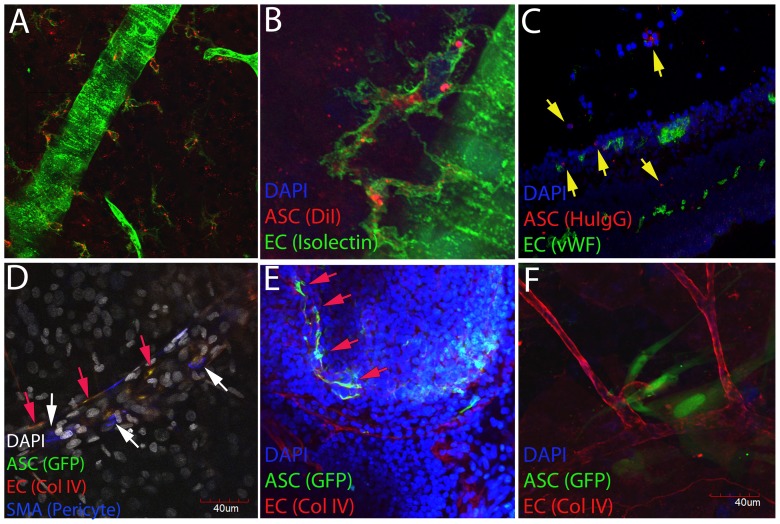
Incorporation of intravitreally delivered ASC into host vasculature in diabetic athymic rats.Two months post diabetes induction or age matched normal rats were intravitreally injected with either saline or ASC (250,000 cells in 2 µL of saline). At day 7 or day 21, rats were euthanized and retinal wholemounts were prepared after various antibodies immunostaining as mentioned in methods. Confocal images of Z-stacks from representative animals demonstrated (A) DiI labeled ASC in close relationship with host vasculature (B) Zoomed from A, (C) co-localization of vWF and human histone IgG within the retina, (D) GFP-ASC co-localized with endothelial Collagen IV (yellow arrows) and pericyte specific αSMA (white arrow heads), (E) GFP-ASC at day 21 assuming perivascular position (yellow arrows) and (F) age-matched non-diabetic rats with GFP-ASC did not co-localize perivascularly with host capillaries.